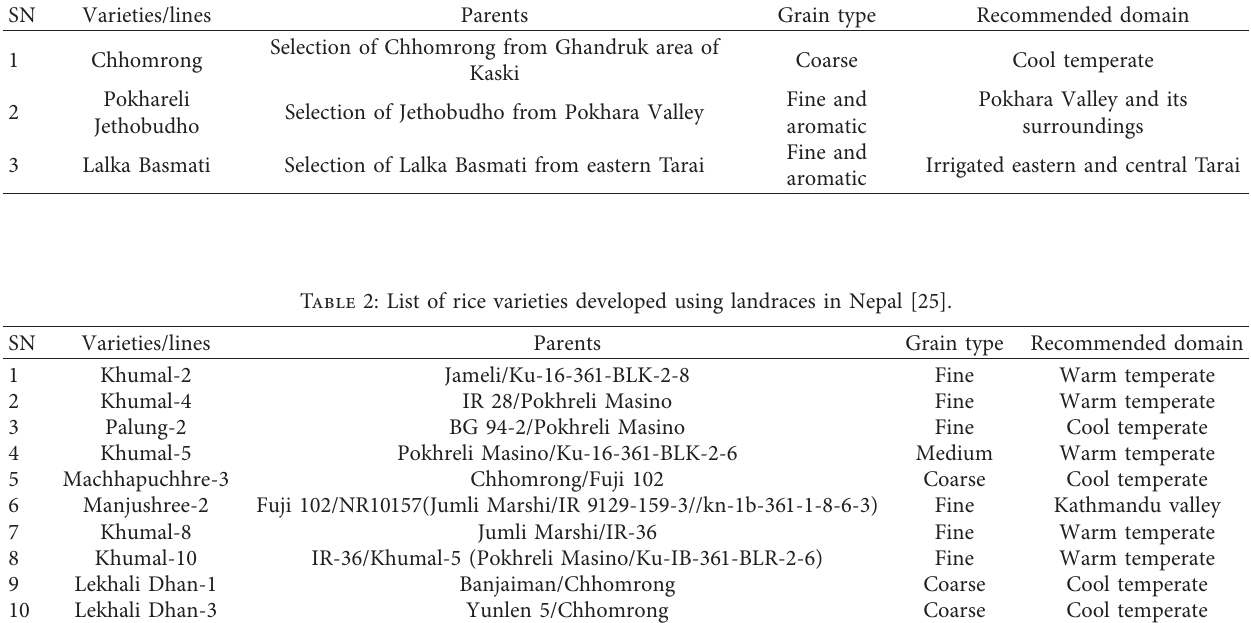
Table 1: List of rice varieties selected from landraces as pure line varieties in Nepal [25]. SN Varieties/lines